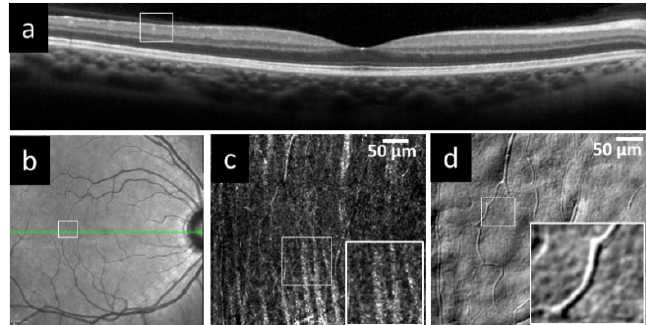
Fig. 2. (a) Optical coherence tomography (OCT) cross-section of healthy volunteer with a rectangle showing were the images were acquired. (b) SLO image of the same volunteer. (c) confocal AOSLO image of the nerve fibers (axons) of the white rectangle region in (a,b). (d) Multi-offset AOSLO images showing the ganglion cells in the same